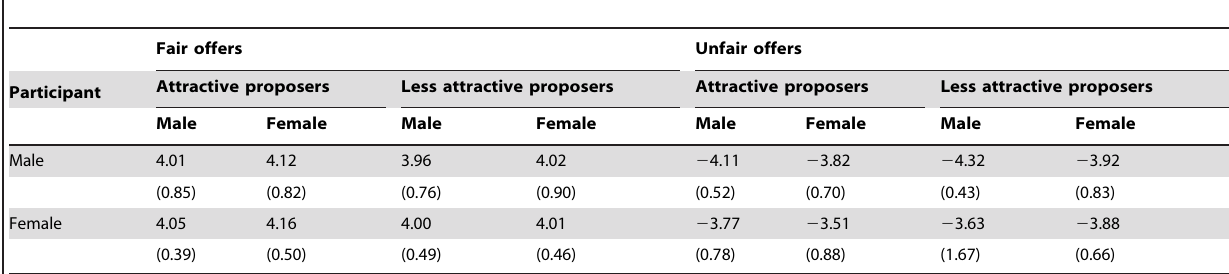
Table 1. Mean scores for participants’ evaluation of the fairness of offers made by attractive and less attractive proposers of the same or the opposite sex (Standard deviations are in